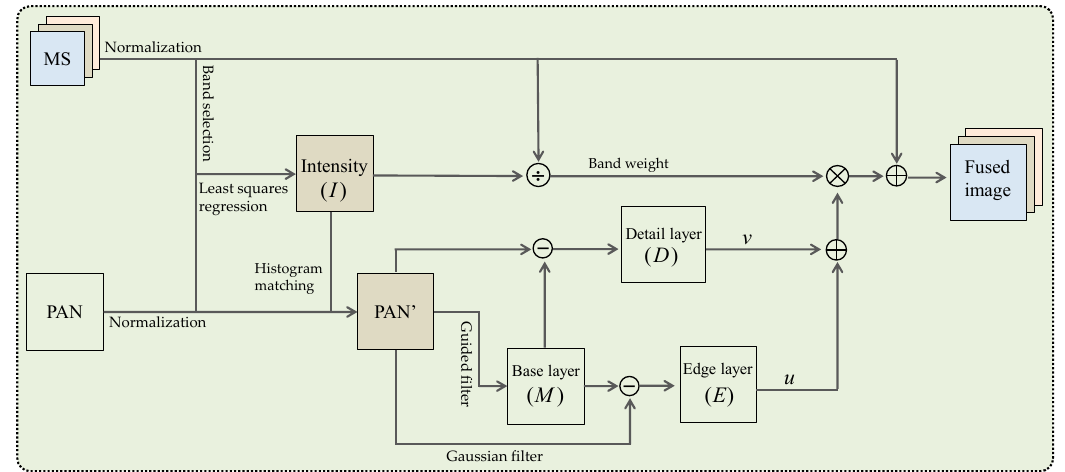
Figure 1. Schematic diagram of the proposed method.